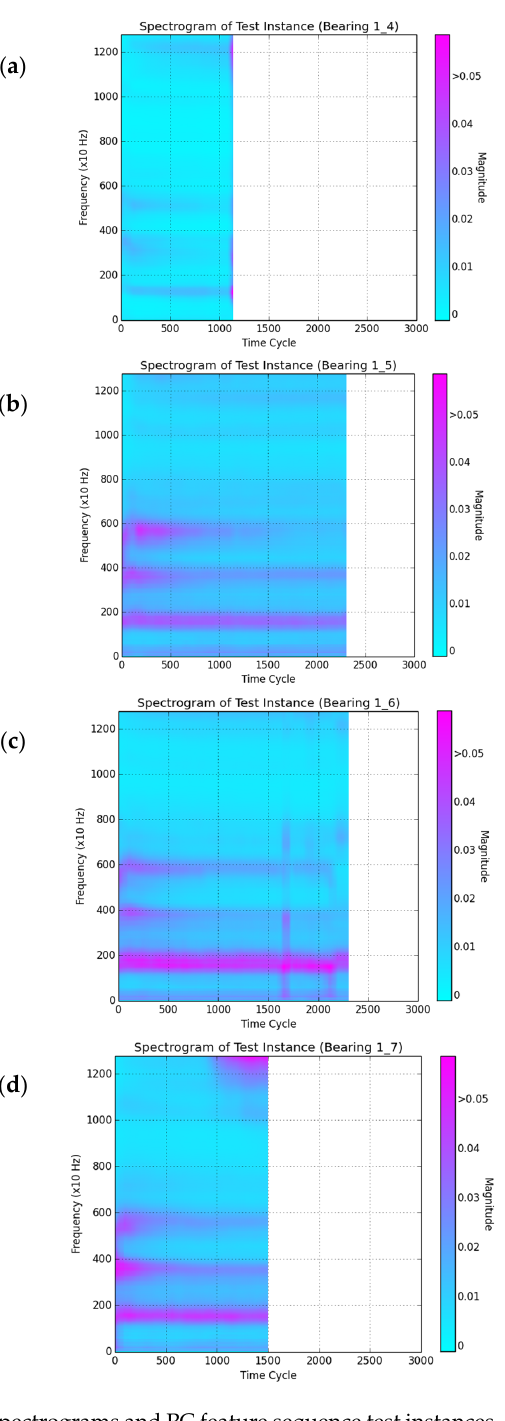
Figure 10. Spectrograms and PC feature sequence test instances. ( a ) Bearing1-4; ( b ) Bearing1-5; ( c ) Bearing1-6; ( d ) Bearing1-7. (Note: The same range of time cycle in x-axis [0–3000] is used for all subfigures to illustrate the large variations of bearing lifespans in the PRONOSTIA datasets.).